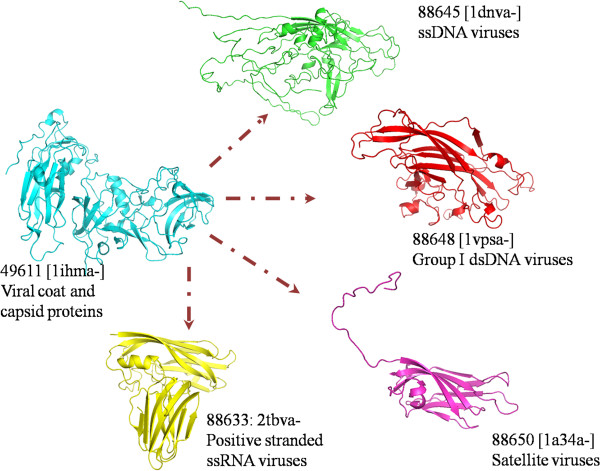
Illustration of splitting of viral protein superfamily [SCOP code: 49611] into four different superfamilies in PASS2_v2008.